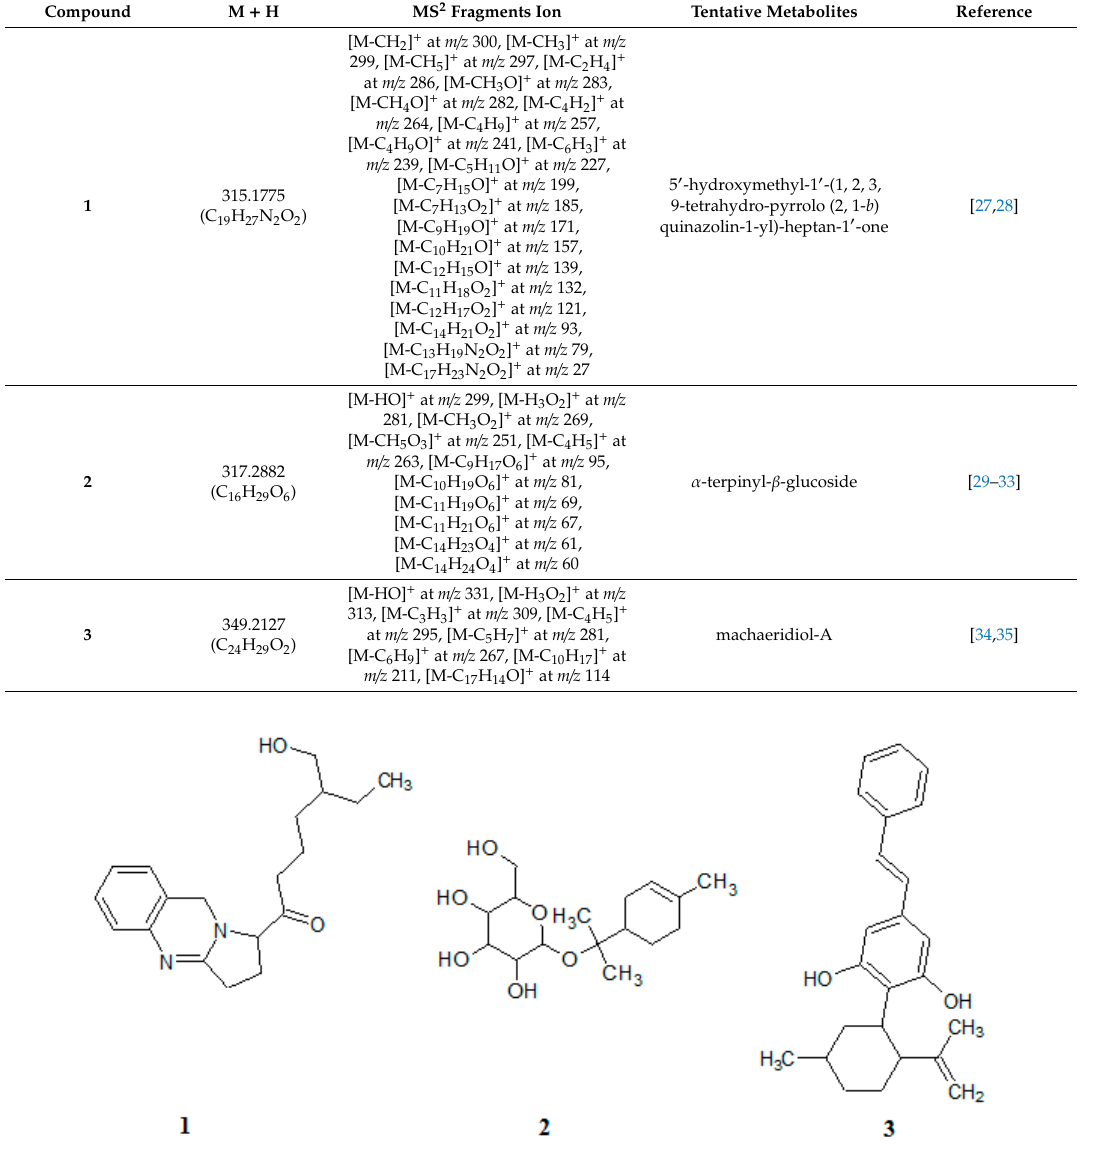
Figure 4. Chemical structures of compound 1 , 2 , and 3 .